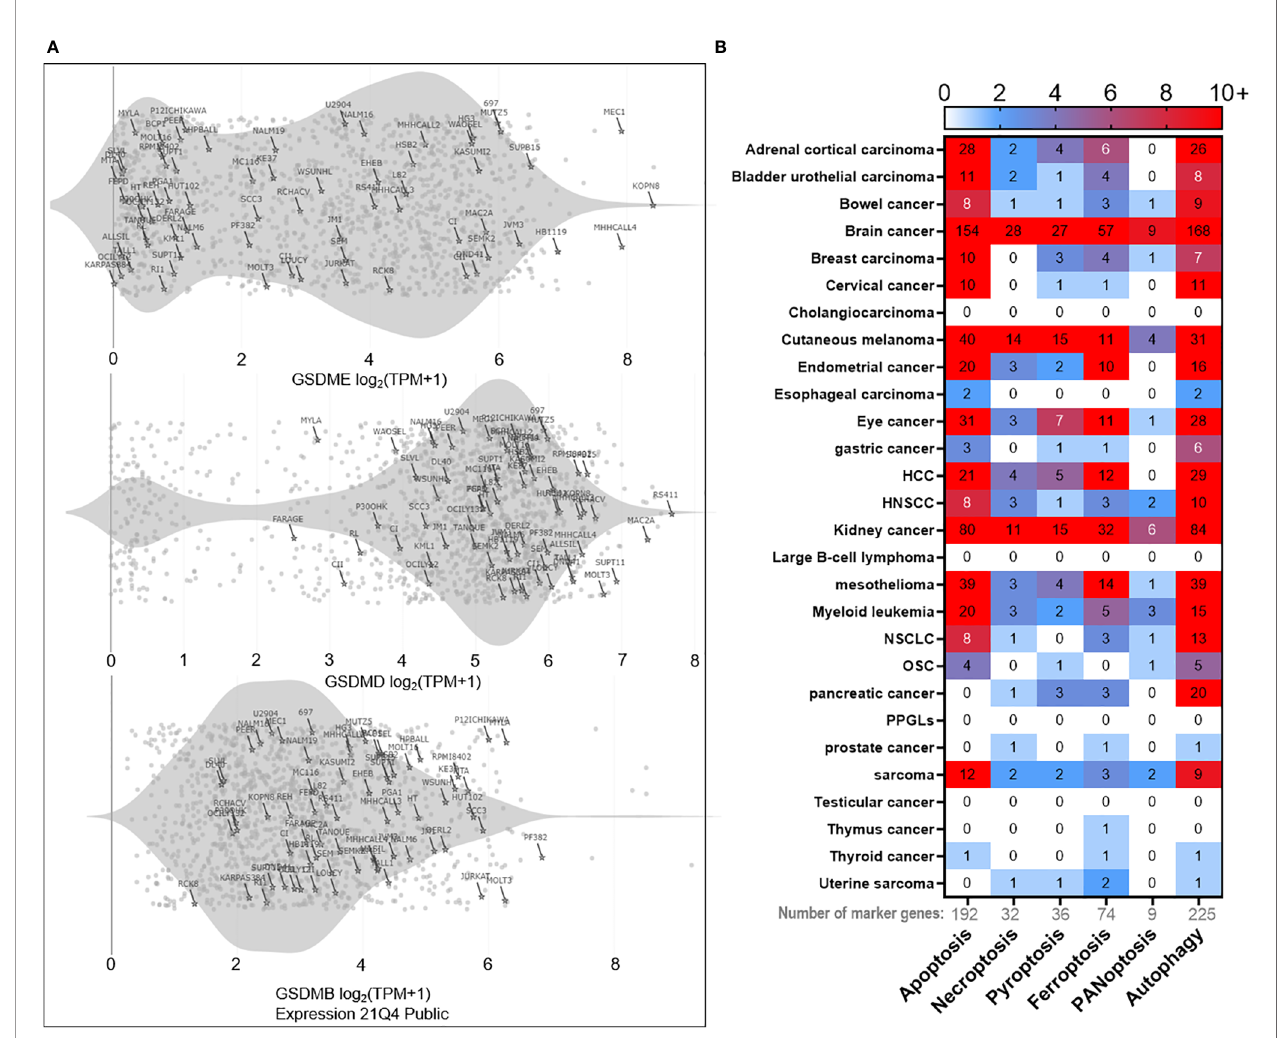
FIGURE 1 | Bioinformatics of PCD landscape. (A) PCD occurs in immune cells as well. For instance, expressions of the pyroptosis marker gene ‘ gasdermin ’ family (GSDME, GSDMD, GSDMB) can be detected in various T and B leukemia cell lines (marked with the cell line name and highlighted with stars) according to Cancer Cell Line Encyclopedia (CCLE) database. The rest of the points represent other types of cell lines deposited in the database. The gray shade represents the distribution density of T and B cell lines. (B) Based on PCD marker genes (192 for apoptosis, 32 for necroptosis, 36 for pyroptosis, 74 for ferroptosis, 9 for PANoptosis, and 225 for autophagy), we analyzed the correlation between each marker gene and the overall survival in pan-cancer. Only those genes with p < 0.01 signi fi cance in correlation are used to plot the heatmap. The numeric mark in the heatmap means the number of marker genes that is signi fi cantly (p < 0.01) correlated with the overall survival. The results reveal heterogeneous contributions of each PCD in the overall survival across cancers. In brief, brain cancer ranks fi rst in overall survival correlation with apoptosis, necroptosis, pyroptosis, ferroptosis, and PANoptosis, followed by kidney cancer, cutaneous melanoma, mesothelioma, adrenal cortical cancer, and others. As for autophagy, it positively correlates with the overall survival in most cancers, with brain cancer being the most signi fi cantly correlated as well. Clinical data are acquired from the TCGA database. Marker gene lists of respective PCD are provided in the Supplementary Excel File . HNSCC, squamous cell carcinoma of the head and neck; HCC, hepatocellular carcinoma; NSCLC, non-small cell lung cancer; OSC, ovarian serous cystic adenocarcinoma; PPGLs, pheochromocytomas, and